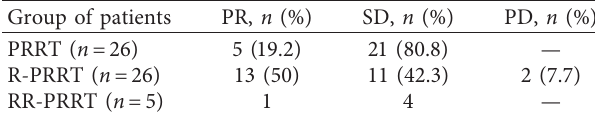
Table 4: Responses to the initial and repeated PRRT. Group of